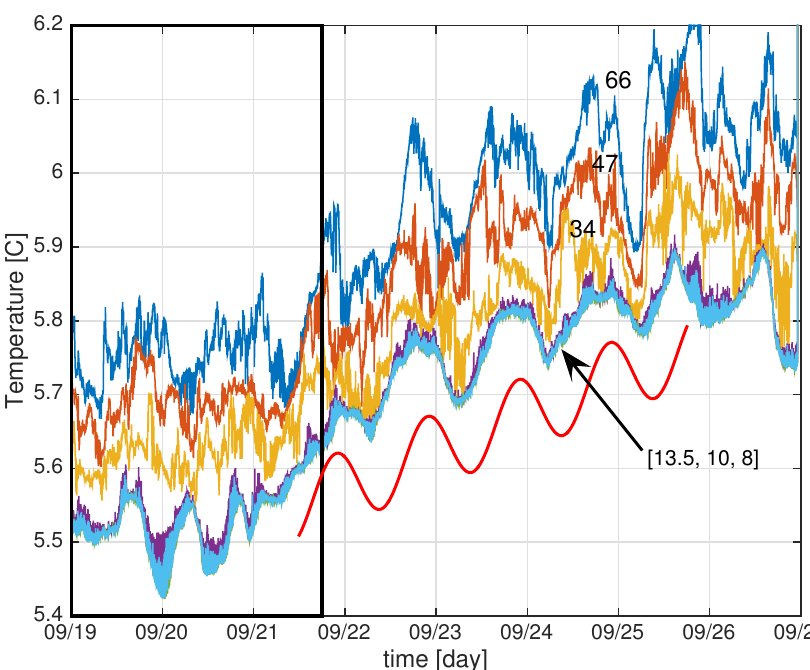
Figure 4. Time series for the 5 SBE and one RBR temperature sensors with H ab indicated. Inertial- diurnal time scales are rendered as a sine wave in the red trace. These frequencies are distinguishable from the slope parallel frequency (6) as that frequency would have five periods rather than four. The box indicates the time interval of the MAVS record.